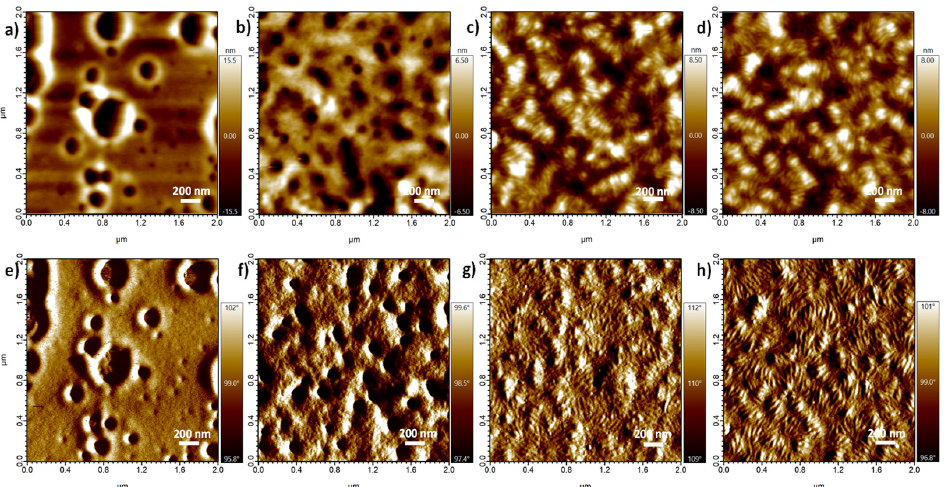
Figure 5. AFM images of P(FDPP-TP): ( a – d ) height images; ( e – h ) phase images at different annealing temperatures; ( a , e ) non-annealed films; ( b , f ) annealed at 100 °C; ( c , g ) annealed at 150 °C; ( d , h ) annealed at 200 °C.